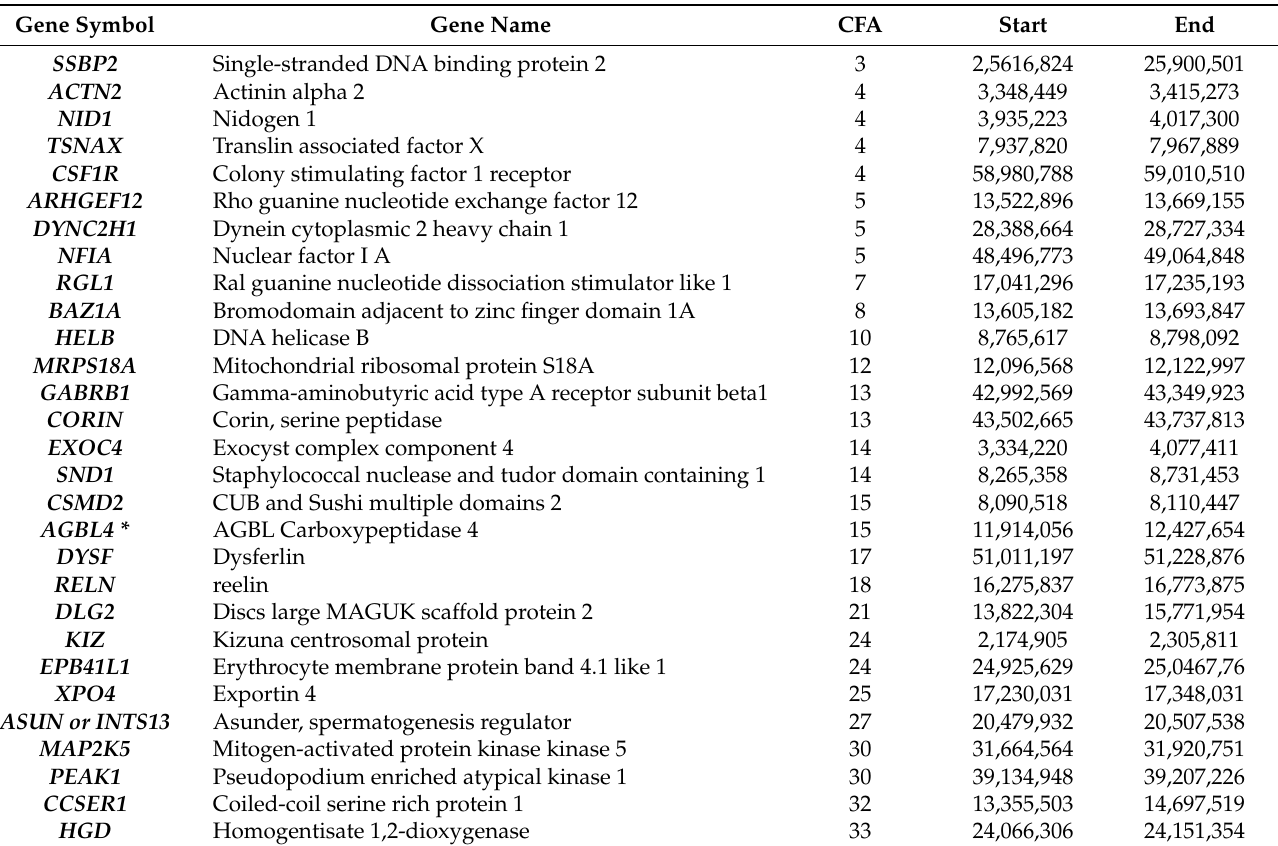
Table 1. List of genes shared between Wright’s fixation index (F ST ) and single SNP cross-population extended haplotype homozygosity (XP-EHH) analyses comparing livestock guardian and herding shepherd dogs.